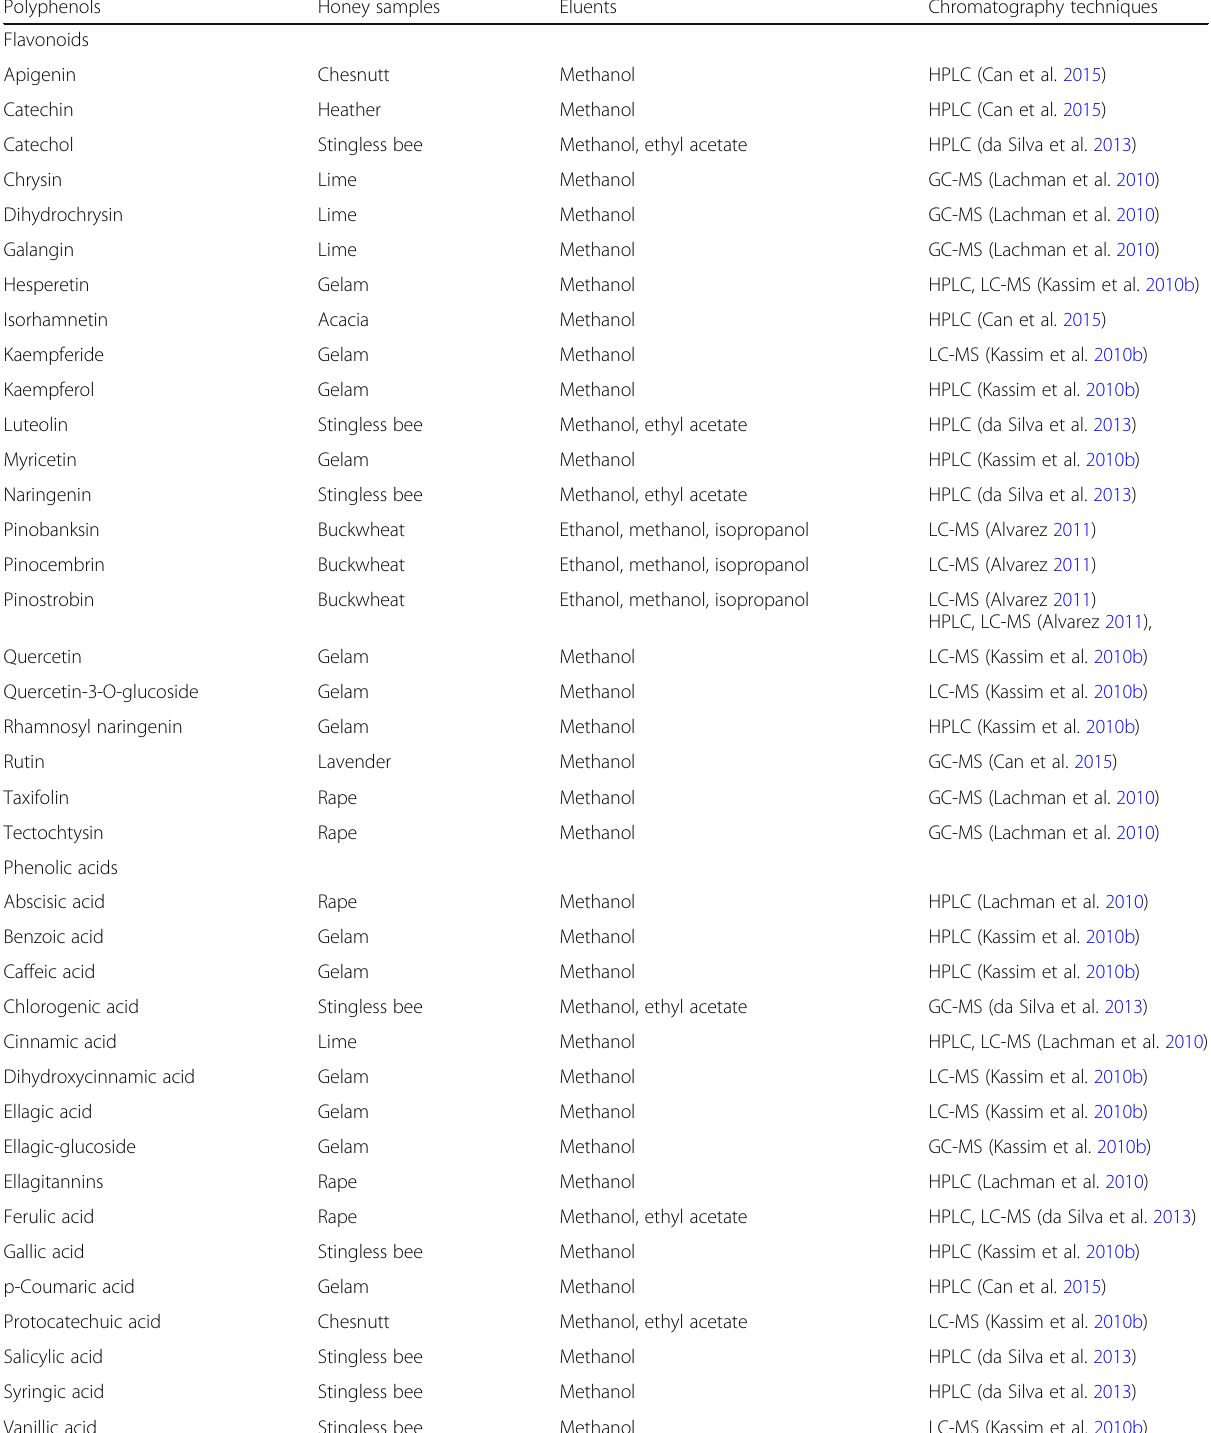
Table 1 Characterization of polyphenols as verified by different chromatography techniques Polyphenols Honey samples